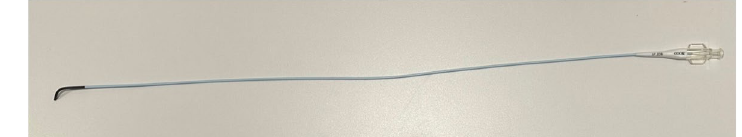
Fig. 6 Kumpe catheter (Cook Inc. Bloomington, IL). The short (40 cm) length is ideal for this